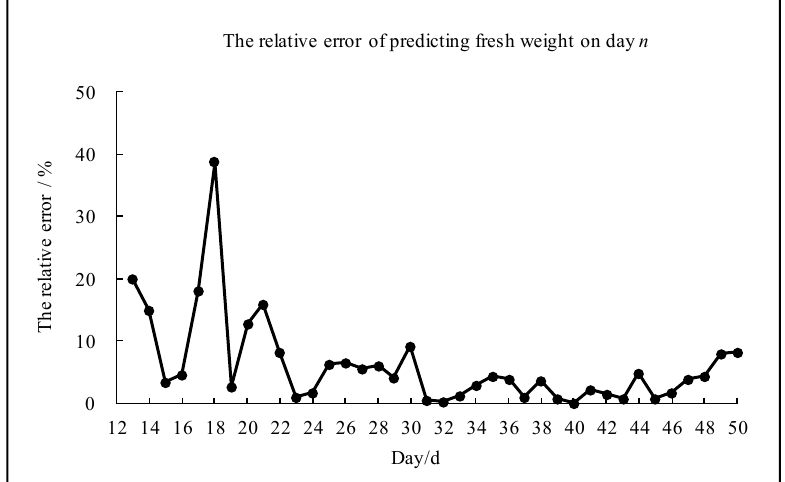
Figure 9. The relative error of predicting fresh weight using only the data from the current batch. Table 2. Prediction of fresh weight error over the next 3